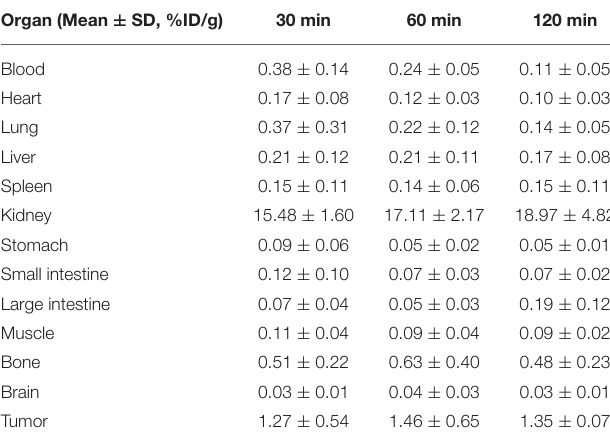
TABLE 1 | Biodistribution of the [ 18 F]AlF-NOTA-HER2 affibody in mice-bearing NCI-N87